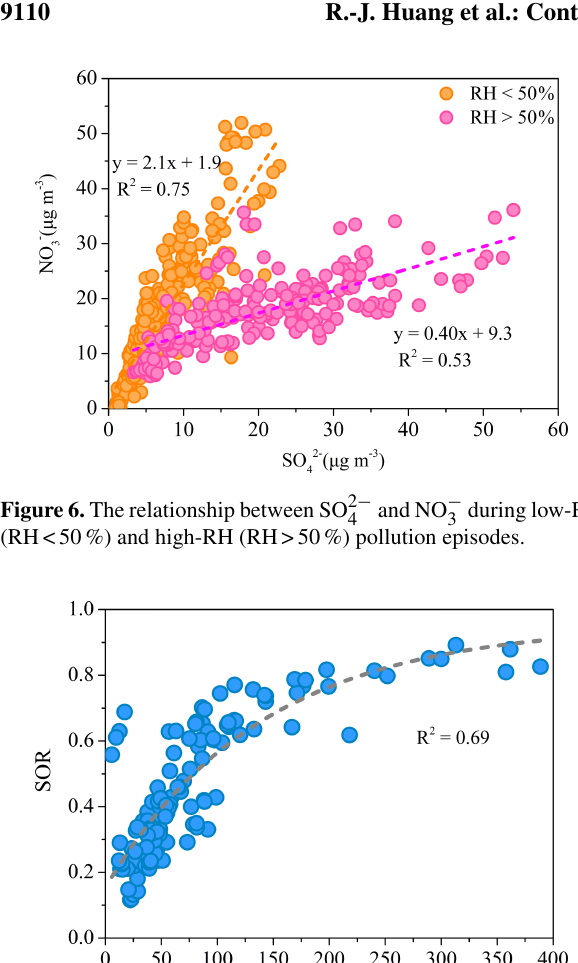
Figure 7. The relationship between the sulfate oxidation ratio (SOR = [SO 2 − ]/([SO 2 − ] + [SO 2 ]) and ALWC at high-RH pollution con- 4 4 ditions